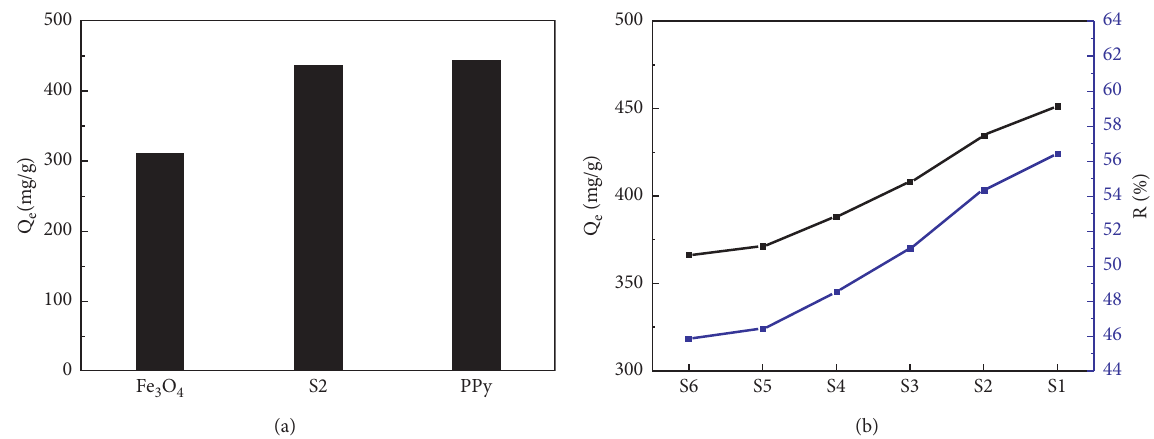
Figure 8: Adsorption capacity of (a) Fe 3 O 4 , PPy, and S2 and (b) various Fe 3 O 4 /PPy nanotubes for Cr(VI).